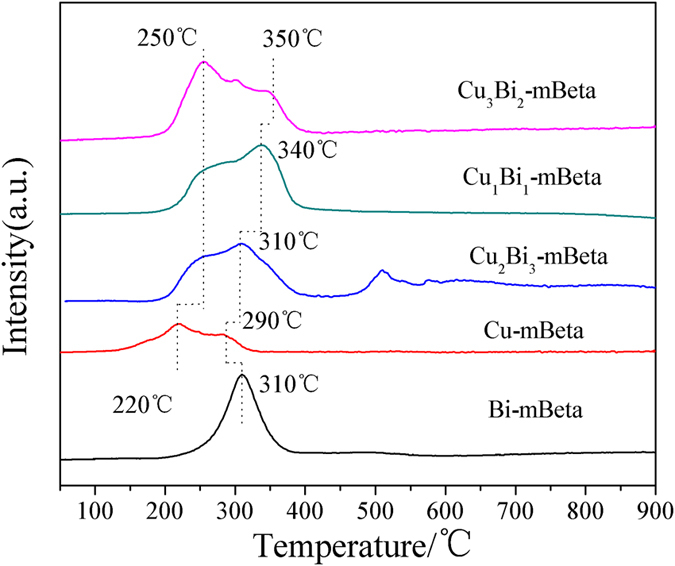
H2-TPR profiles of Cu-mBeta, Bi-mBeta and CuxBiy-mBeta samples.